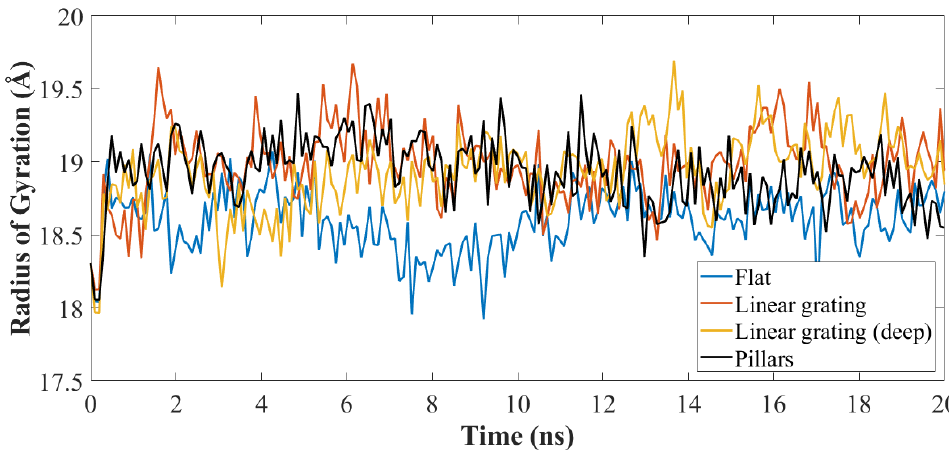
Figure 5. Radius of gyration for different nanoscale topographies. Table 1. Initial and final BMP-2 secondary structure.